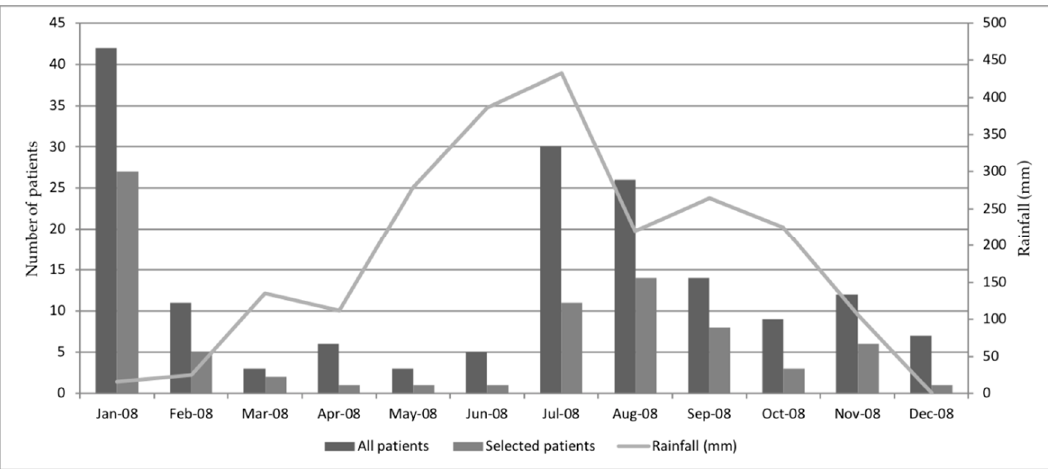
Figure 1. Distribution over time of patient sample received in the laboratory in 2008 for suspicion of dengue infection. Patient with suspicion of dengue infection are patients with clinical signs meeting dengue criteria following WHO guideline [14].